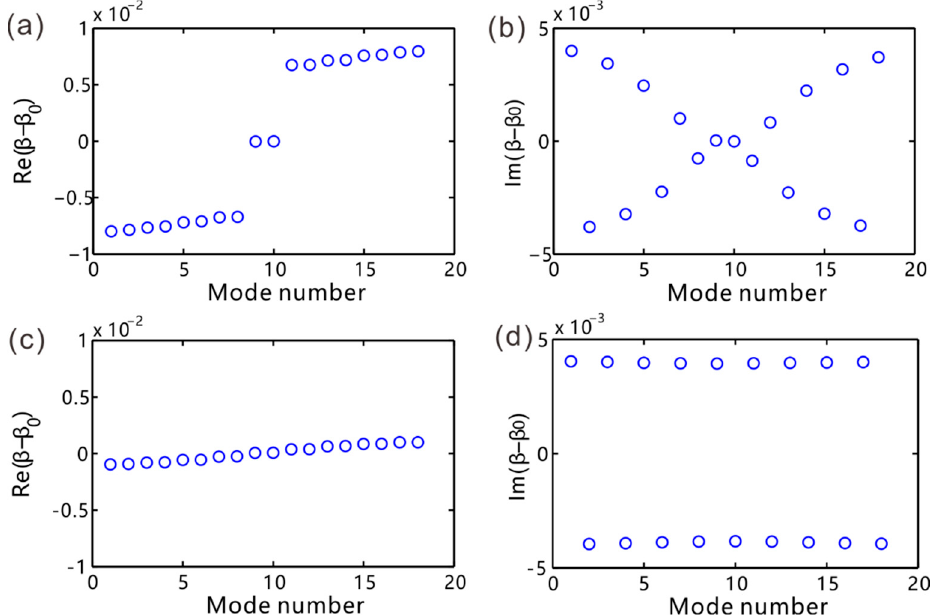
Figure 4. The propagation constants in finite waveguide arrays for two di ff erent coupling strengths. ( a ) and ( b ) are the real and imaginary parts of propagation constants as c 1 > c 2 . ( c ) and ( d ) are the real and imaginary parts of propagation constants as c 1 < c 2 .